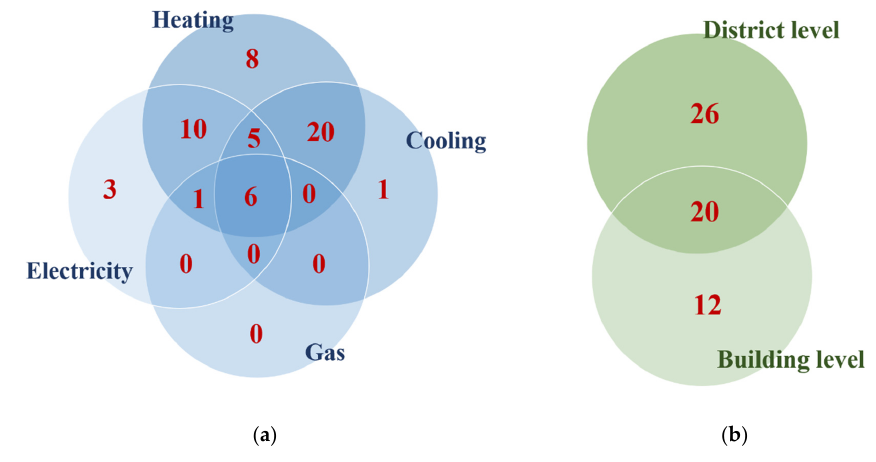
Figure 6. Number of projects per ( a ) energy vectors involved ( b ) and main application.